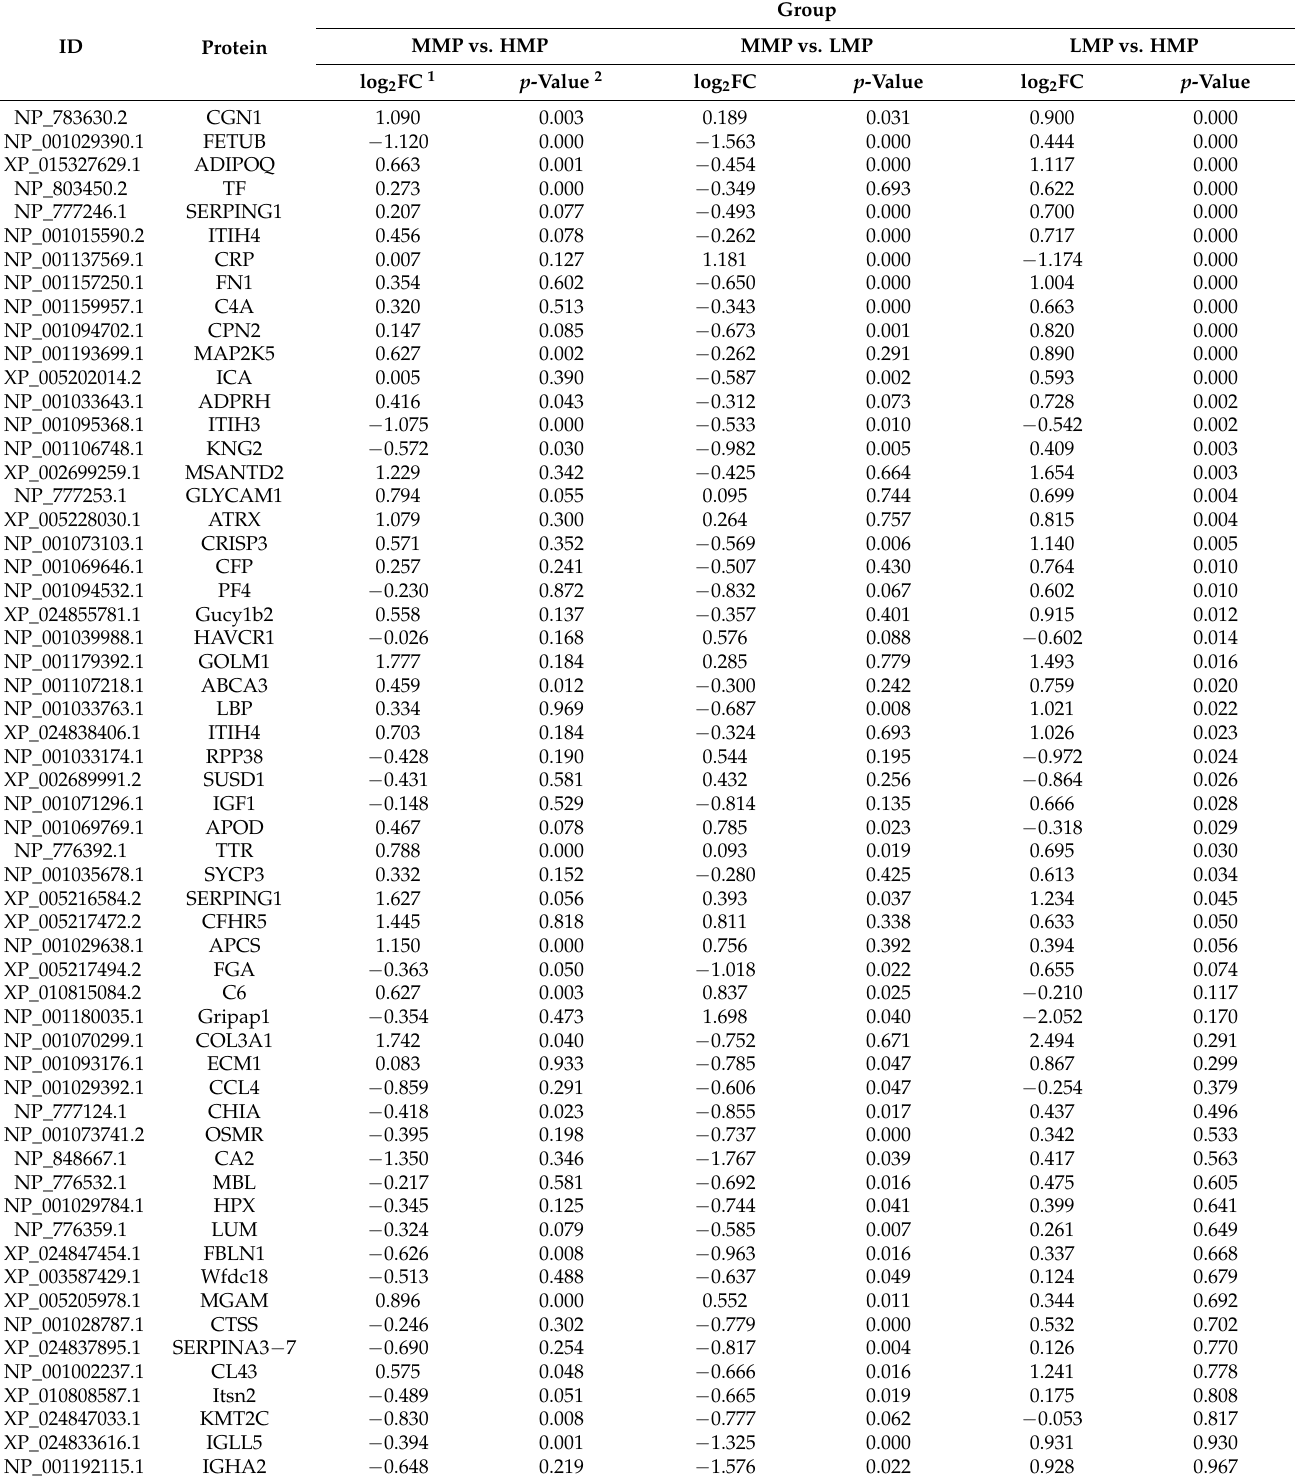
Table 2. Differentially expressed protein in plasma ( p < 0.05, FC >